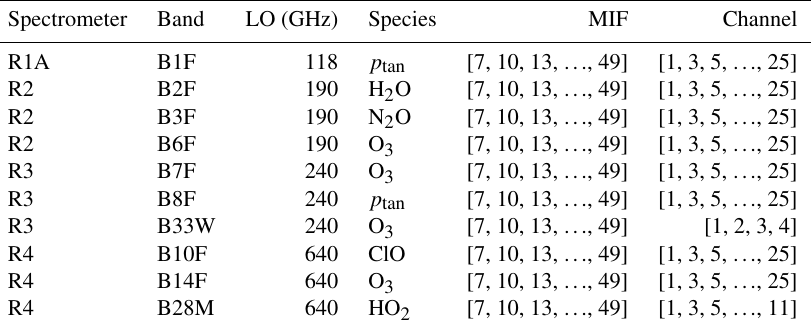
Table 1. Details of the input variables for the ANN algorithm, which consist of MLS brightness temperature observations in 10 different bands from 4 radiometers. Besides the official radiometer and band designations, the local oscillator (LO) and primary species of interest in the respective band are given, as well as the ranges of minor frames (MIFs) and channels used as input for the ANN. Spectrometer Band LO (GHz) Species MIF Channel R1A